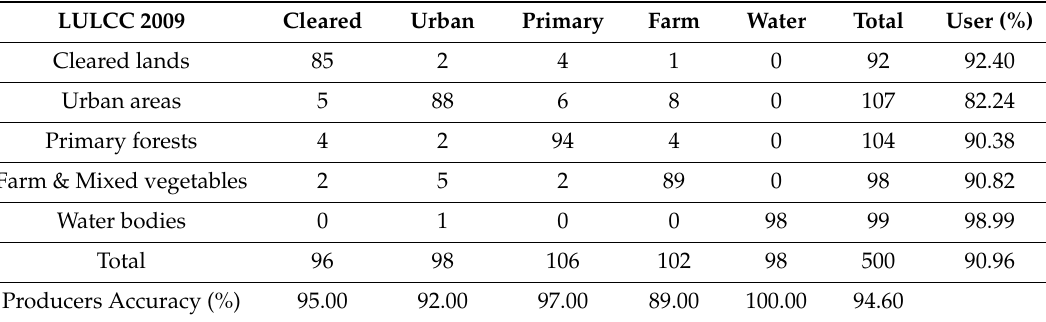
Table 8. Confusion matrix table of 2009 land cover